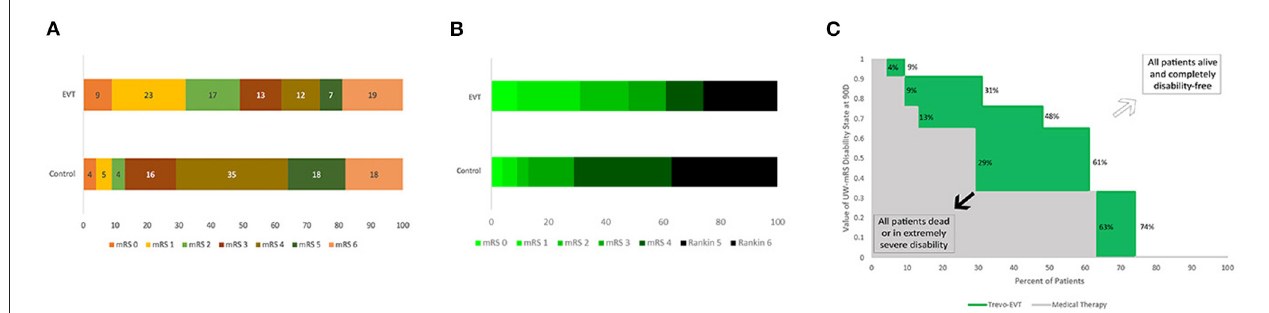
FIGURE 1 | Comparative Standard Stacked Bar Chart, Choropleth Stacked Bar Chart, and Utility Staircase Chart Displays. Outcomes at 3 months on the ordinal modified Rankin Scale from the same trial, DAWN, are shown using each figural approach: (A) Standard stacked bar chart–display visually conveys mRS rank frequencies (bar segment widths), but does not explicitly visually communicate utility values; (B) Choropleth stacked bar chart–display visually conveys both mRS rank frequencies (bar segment widths) and mRS rank utility values (degree of green intensity); and (C) Utility Staircase chart–display visually communicates both mRS rank frequencies (row widths) and mRS rank utility values (column heights). In addition, display directly communicates utility value of the two treatment groups: utility value of control treatment–area size of gray coloration; utility value of active treatment–area size of combined gray and green coloration; utility gain with active treatment–area size of green